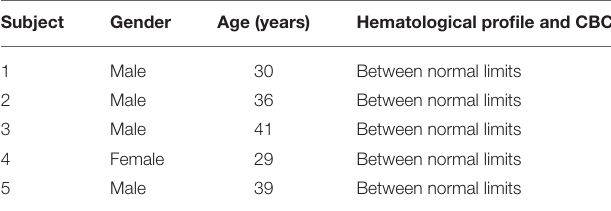
TABLE 1 | Profile of volunteers whose blood was used in the